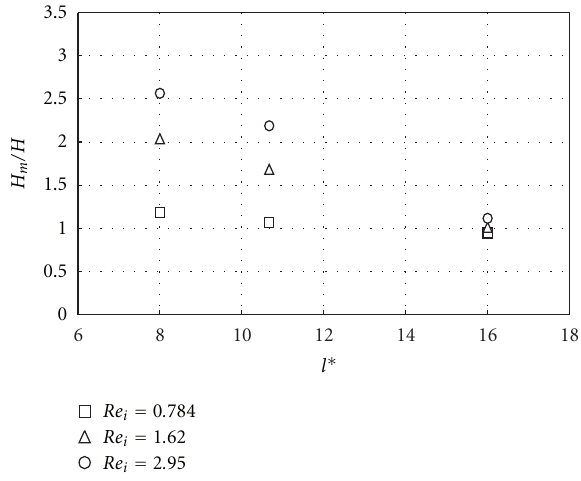
Figure 15: Ratio of multiple flame length to single flame length as a function of interburner spacing and injection velocity for 100% CH 4